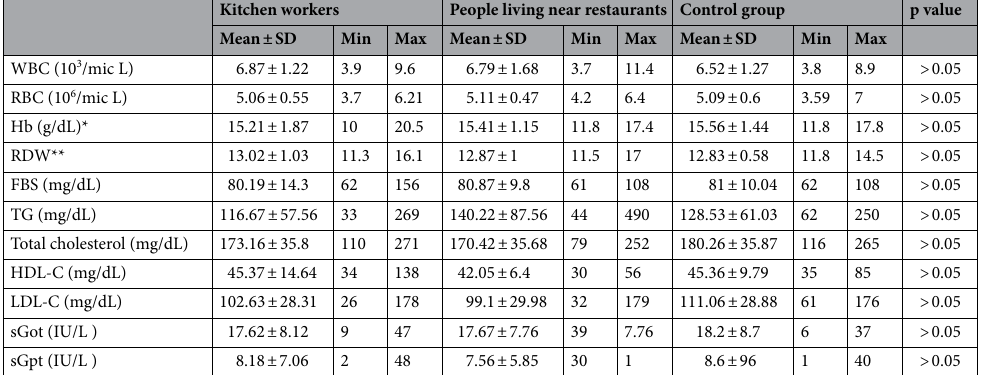
Table 2. A comparison of the levels of the clinical parameters in the blood samples from the different study groups. *Hb (hemoglobin), **RDW (red blood cell distribution with).